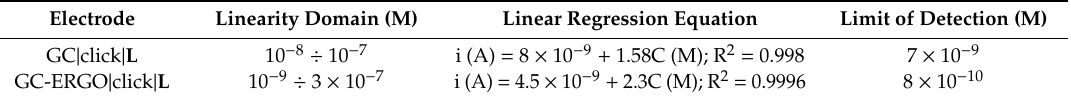
Figure 8. Typical DPV curves ( A , C ) and calibration plots ( B , D ) for Hg(II) analysis with GC|click| L ( A , B ) and GC-ERGO|click| L ( C , D ) modified electrodes. All DPV curves are background corrected. Table 3. Analytical performance of GC|click| L and GC-ERGO|click| L modified electrodes for Hg(II) sensing.